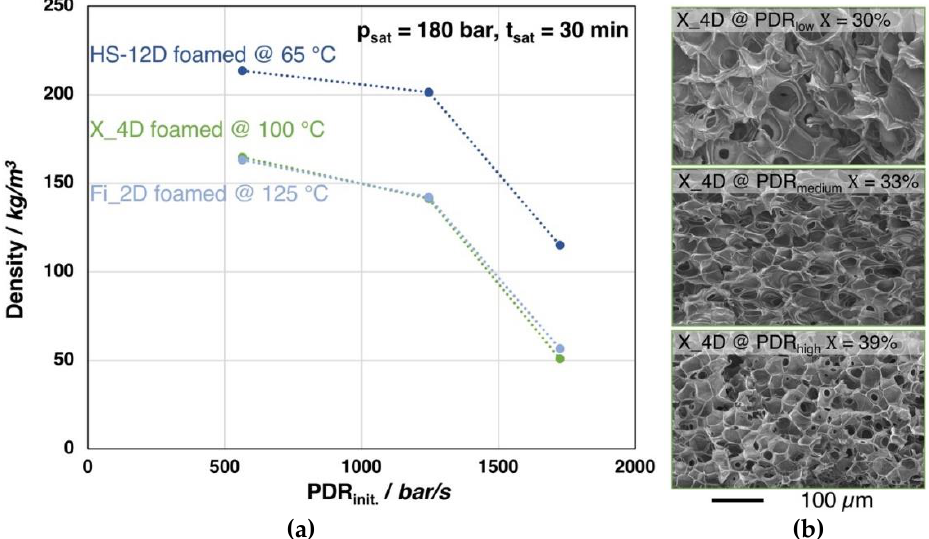
Figure 11. ( a ) Foam densities of the grades Fi_2D, X_4D and HS_12D (with similar molecular weight but varying D-contents) foamed after 30 min. saturation with CO 2 at 180 bar and varied pressure drop rates. ( b ) SEM images of the X_4D foams with different pressure drop rates and crystallinity values (1 st heating).